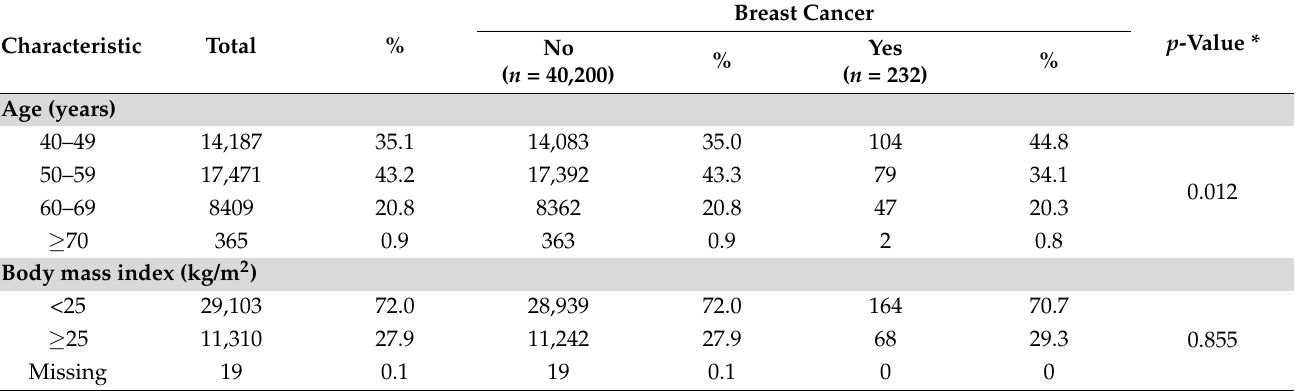
Table 1. General characteristics of participants according to breast